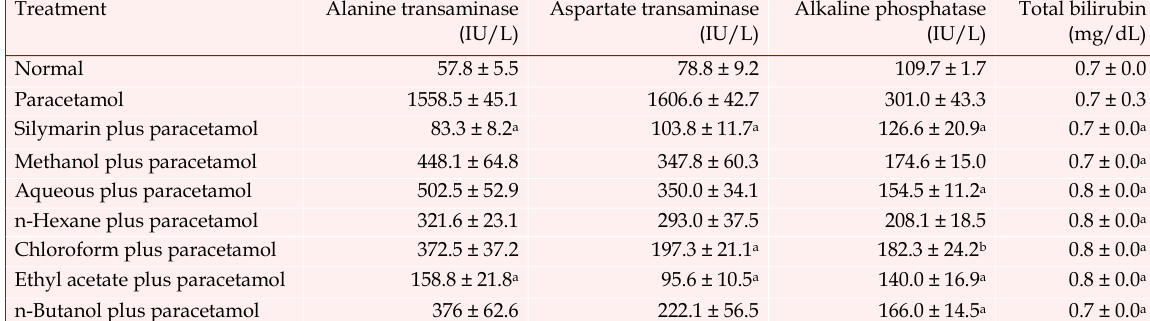
Effect of different fractions of Misopates orontium on serum enzyme levels in acute hepatotoxic rat